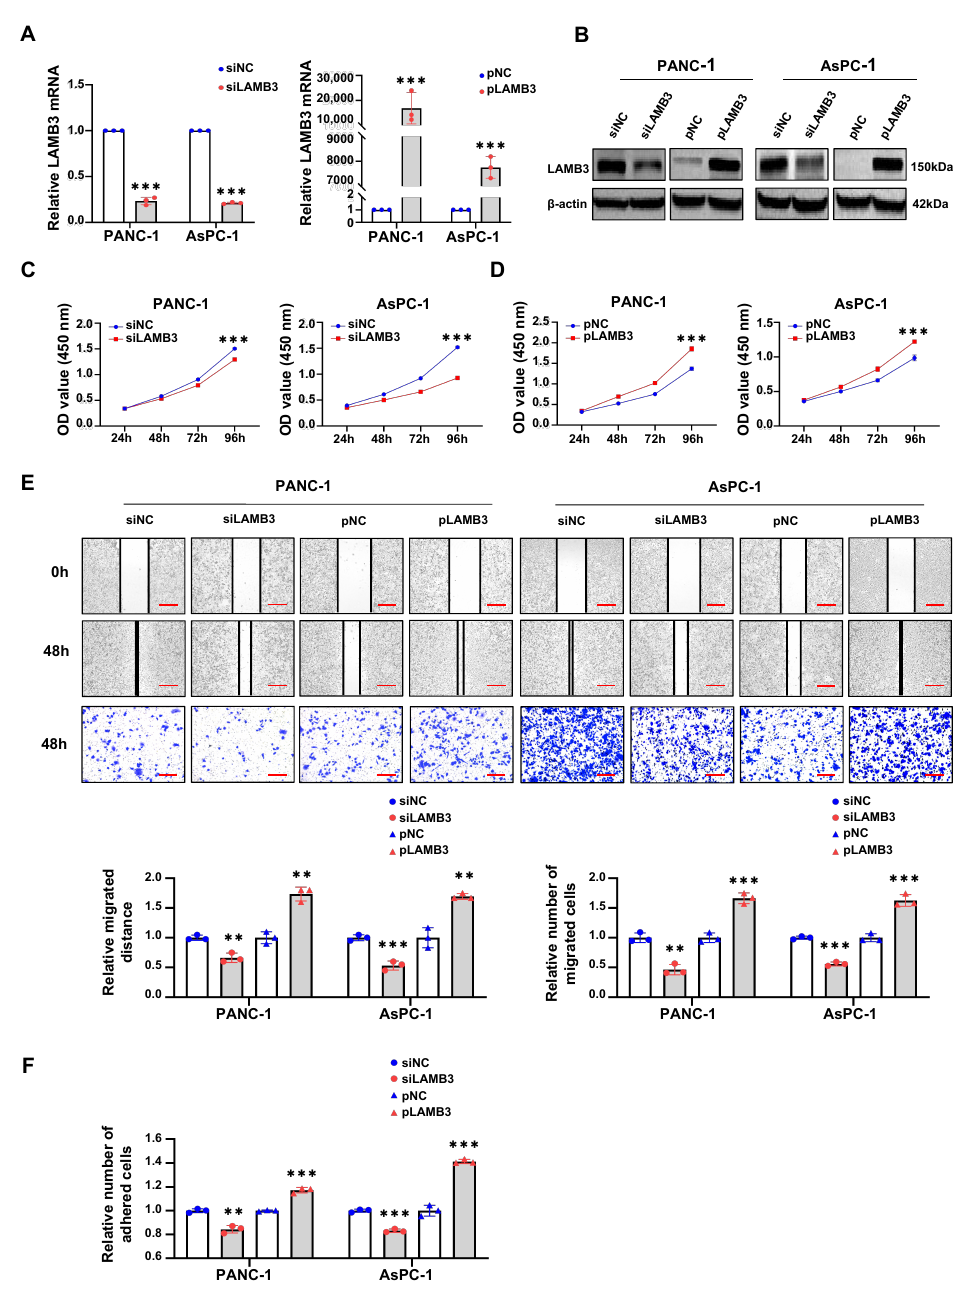
Figure 6. LAMB3 promotes PDAC cells proliferation, migration and adhesion in vitro. ( A , B ) RT- qPCR and Western blotting were used to measure the expression of LAMB3 in PANC-1 and AsPC-1 cells after transfection with a siRNA against LAMB3 (siLAMB3) or control siRNA (siNC), a plasmid to over-express LAMB3 (pLAMB3) or control plasmid (pNC) for 48 h. ( C , D ) After transfection with siNC, siLAMB3, pNC or pLAMB3 for 48 h, cell proliferation of PANC-1 and AsPC-1 cells were determined by CCK-8 assay at indicated time points ( n = 3). ( E ) After transfection with siNC, siLAMB3, pNC or pLAMB3 for 48 h, cell migration of PANC-1 and AsPC-1 cells were determined by cell scratch assay and transwell migration assay at indicated time points ( n = 3). Scale bar: 200 um. ( F ) After transfection with siNC, siLAMB3, pNC or pLAMB3 for 72 h, cell adhesion of PANC-1 and AsPC-1 cells were determined by cell adhesion assay ( n = 3). The transfection concentrations of siRNAs and plasmids were 100 nM and 2.5 ng/uL, respectively. ** p < 0.01 and *** p < 0.001 by Student’s t -test. Whole western blot images are showed in Figure